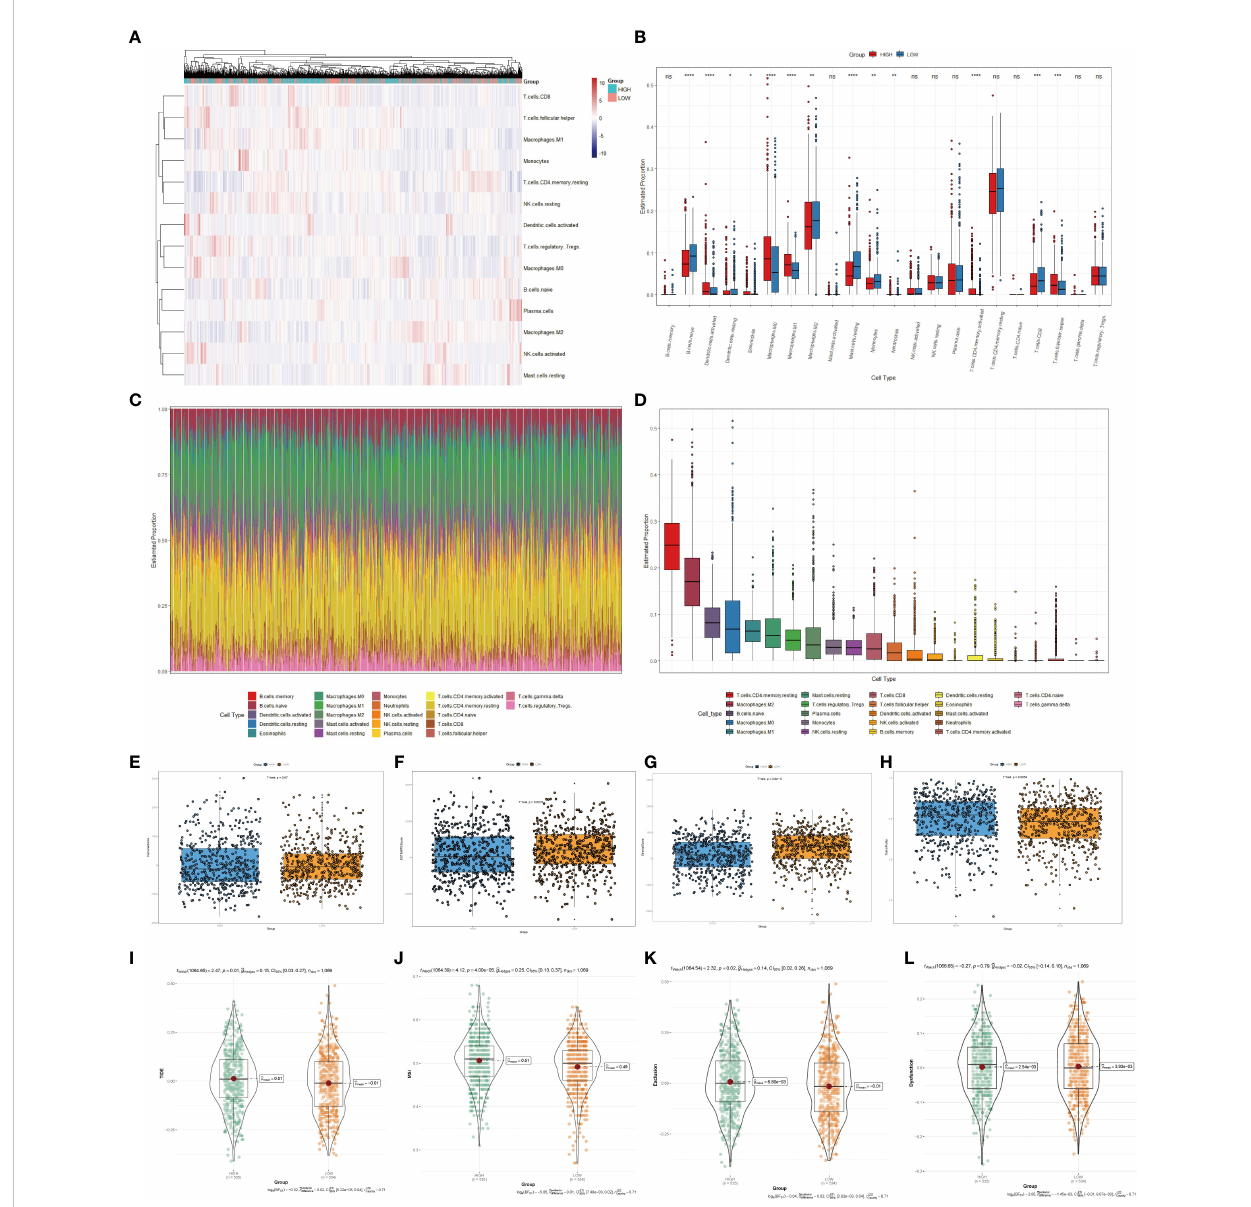
FIGURE 5 Immune cells in fi ltration analysis of the high- and low-scoring groups. Heatmap (A) and box plot (B) of immune cell abundance in breast cancer samples. (C) Histogram of the proportion of immune cells in each sample. (D) Box plot of the proportion of different immune cells ( *p < 0.05; **p < 0.01; ***p < 0.001, ****p< 0.0001 ). Box plots of the immune score ( p =0.67) (E) , ESTIMATE score ( p < 0.01) (F) , stromal score ( p <0.0001) (G) and tumor purity ( p < 0.01) (H) of the high- and low-scoring groups were calculated by ESTIMATE algorithm. Violin plots of Tide ( p =0.01) (I) , MSI ( p < 0.0001) (J) , Exclusion ( p =0.02) (K) , and Dysfunction ( p =0.79) (L) of the high- and low-scoring groups were calculated by TIDE algorithm. (NS: no signi fi